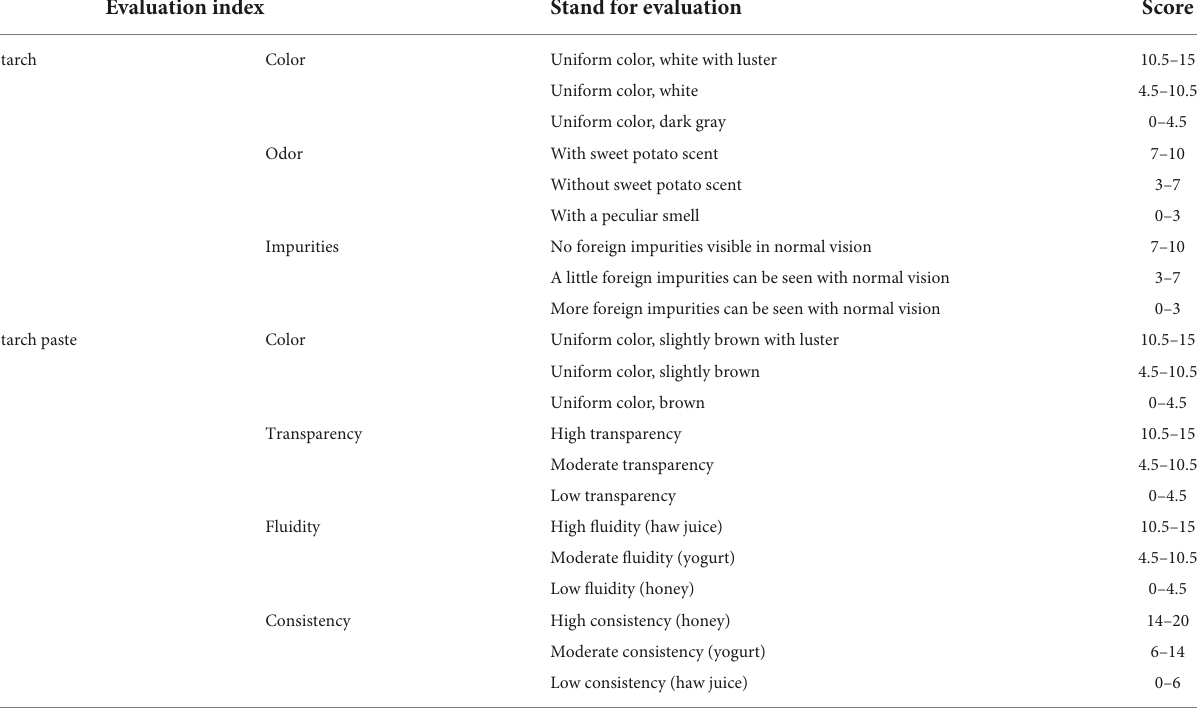
TABLE 9 Sensory evaluation indexes of sweet potato starch.